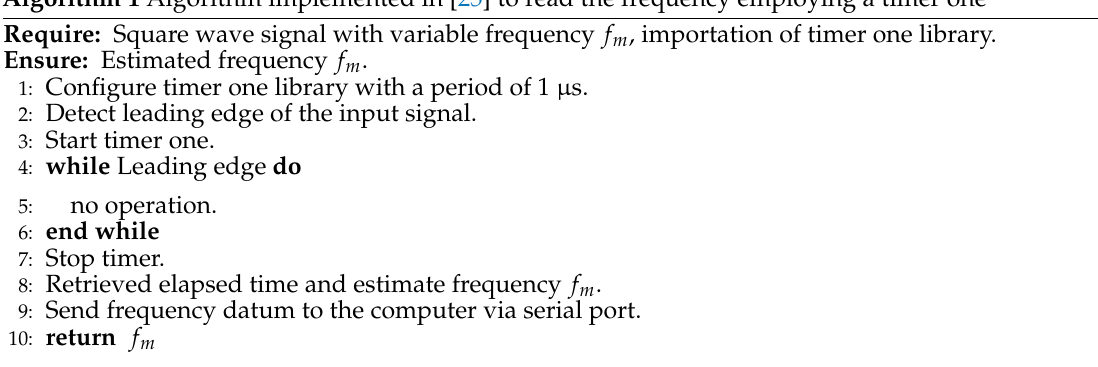
Algorithm 1 Algorithm implemented in [25] to read the frequency employing a timer